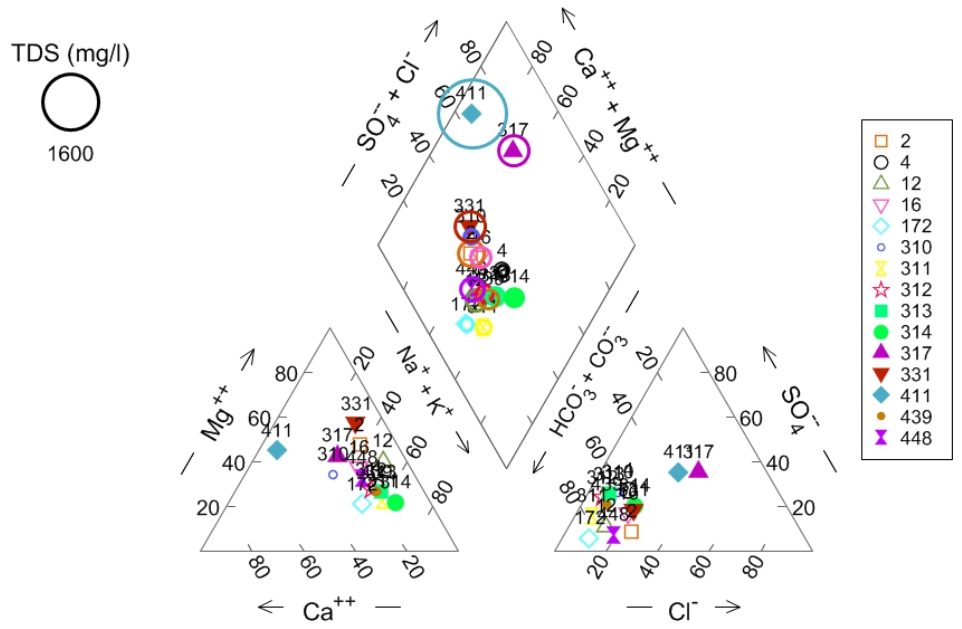
Figure 4. The Piper diagram of groundwater type in the Kabul Basin.